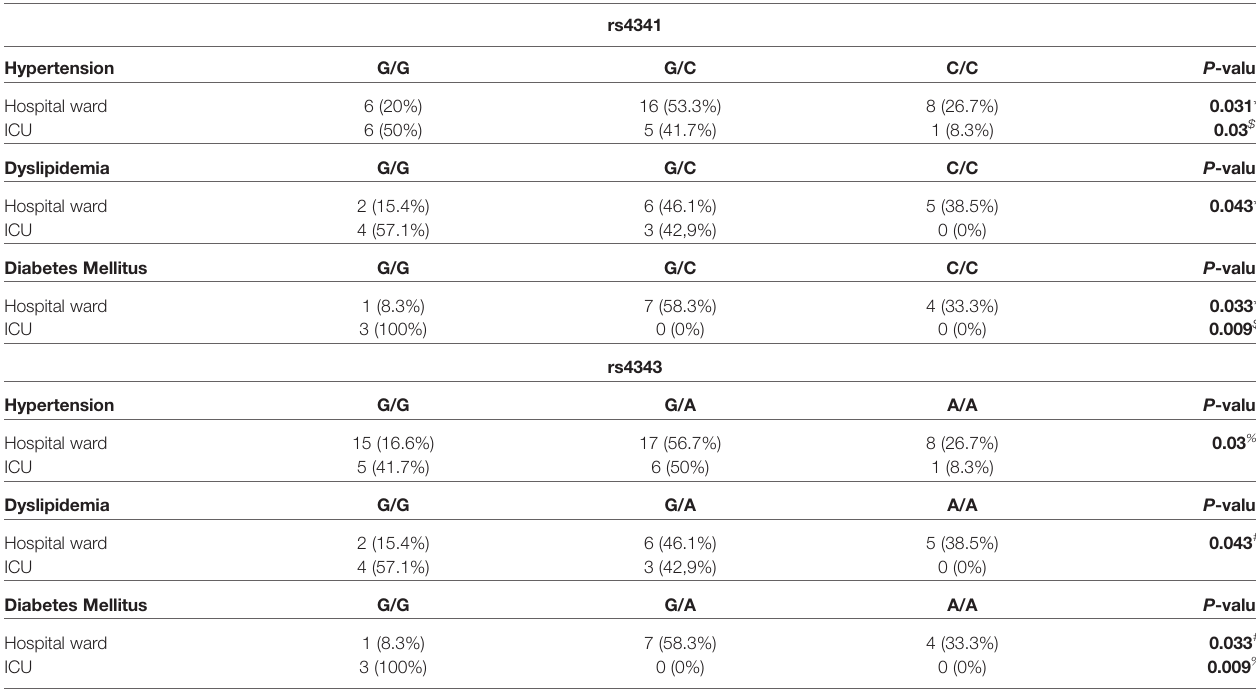
TABLE 2 | Genotype frequencies of rs4341 and rs4343 polymorphisms in COVID-19 patients according to its hypertensive, dyslipidemic or diabetic